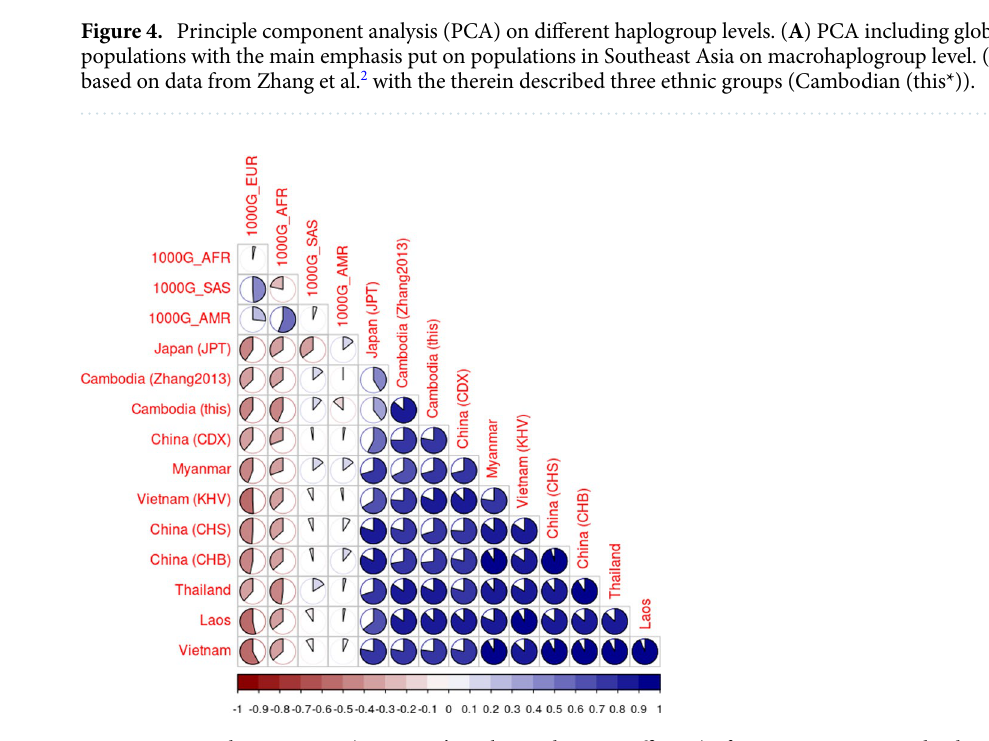
Figure 5. Correlation matrix (Spearman’s rank correlation coefficient) of countries on a macrohaplogroup level. Cambodia (this) represents the 264 Cambodian samples with 35 samples removed due to kinship relations. Blue colours indicate positive correlation coefficients, while red colours indicate negative correlation coefficients. The intensity of the colour and the size of the pie reflect the absolute value of the rank correlation